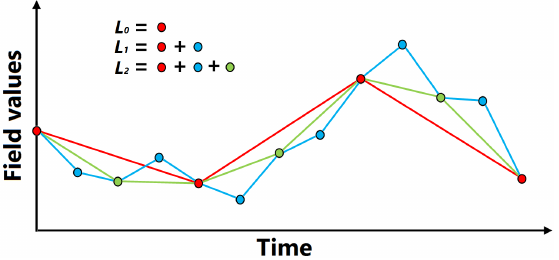
Figure 4. Illustration of hierarchical LOD scheme for function plots with resolutions L 0 = 4, L 1 = 2 · L 0 − 1 = 7, and L 2 = 2 · L 1 − 1 =